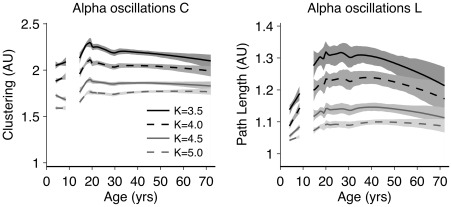
Average degree K marginally influences the developmental profiles of graph parameters C and L. C and L development from connectivity matrices of alpha (6–13 Hz) oscillations are shown.A loess smooth is surrounded by 95% confidence intervals. Marked differences can be seen in the developmental plots, most prominent is the steady decrease in both C and L (relative to the random case) with increased K with a relatively intact curvature; this shape–not the absolute level–reveals the development and comparison between age groups. Some of these age effects were consistent across levels of K: 1) An increase during adolescence in both C (about 16 to 19 yrs) and L (about 16 to 20 yrs)–indicating that brain development is not finished until young adulthood and provides evidence for in increasingly ordered brain networks; 2) Childhood levels of C and L are lower than adolescent and young adult levels. Developmental profiles also differed across levels of K: Adult ages showed a decline in C (for K<4.5) and a strong decline in L (for K<5.0), indicating increased random network organization.